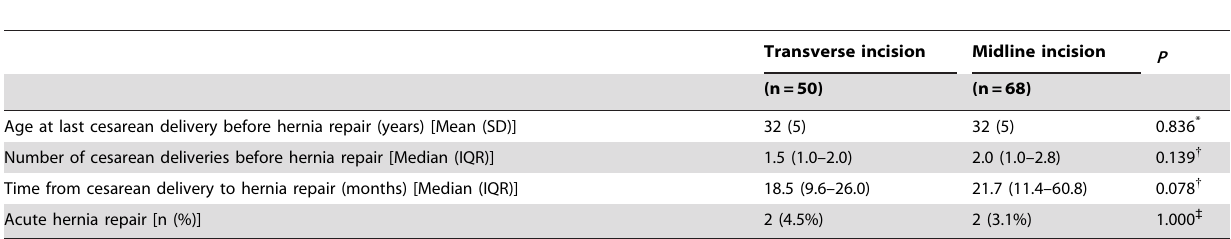
Table 1. Basic characteristics of surgical repairs performed on hernias in midline and transverse